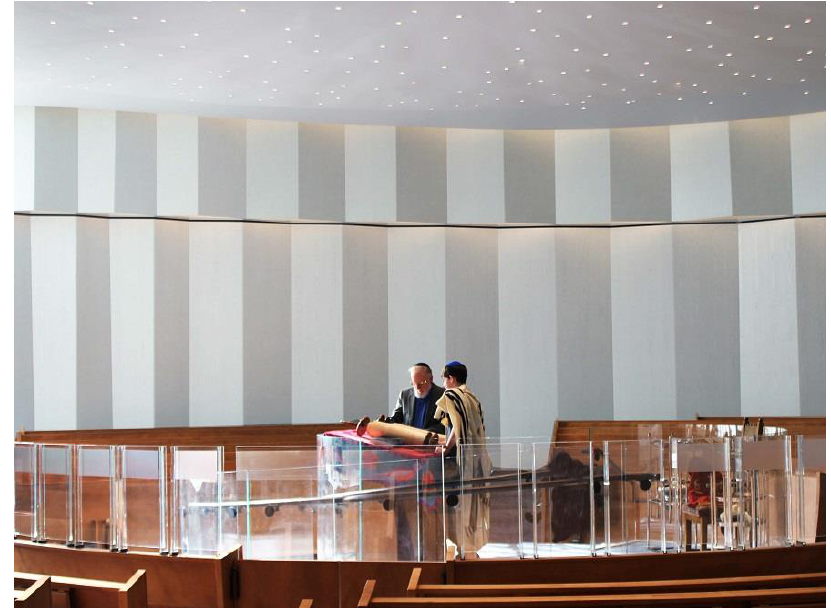
Figure 9. Sanctuary interior. Mechitza around the bima, showing clear and more opaque glass. Photo David Sundberg/ESTO.